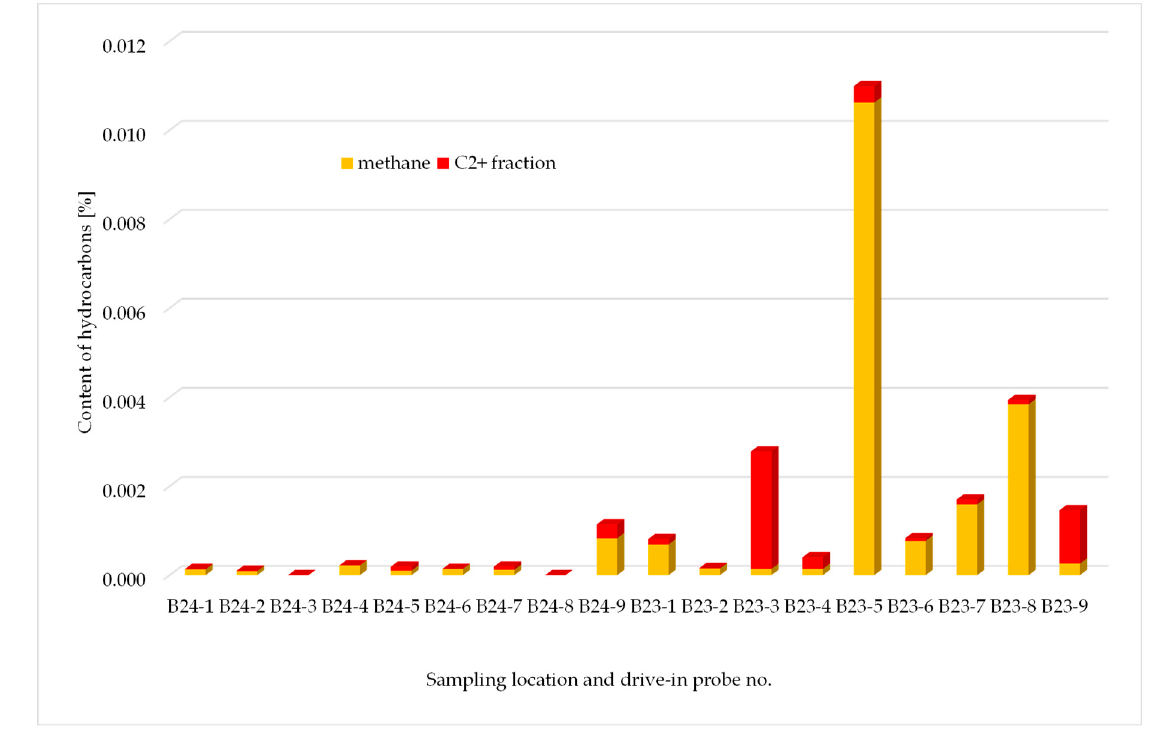
Figure 13. Hydrocarbons content in samples taken at the B-23 and B-24 wells.